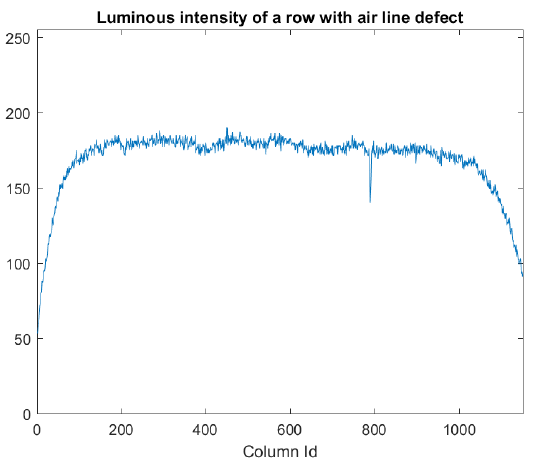
Figure 2. Luminous intensity for pixels that belong to a row with an air line